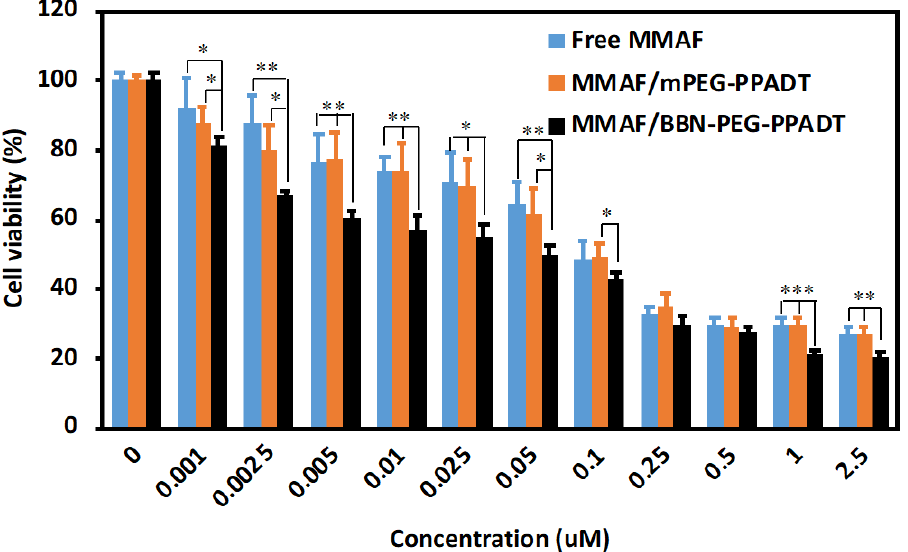
Figure 7. In vitro cell-viability test in the PC-3 cell line. *** p < 0.001, ** p < 0.01, and * p < 0.05, which were analyzed with Student’s t -test.